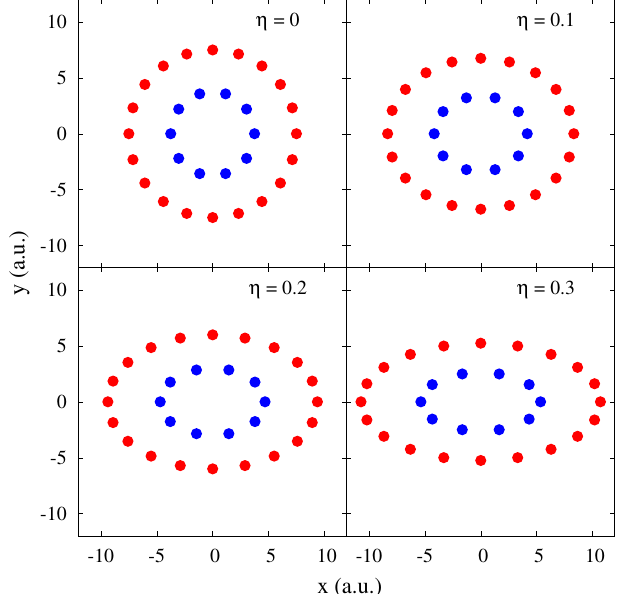
Figure 1. The view along axes of short DWNTs(10, 0)@(5, 0) under different radial strains: (left top) η = 0 (perfect nanotube); (right top) η = 0.1; (left down) η = 0.2; (right down) η = 0.3,